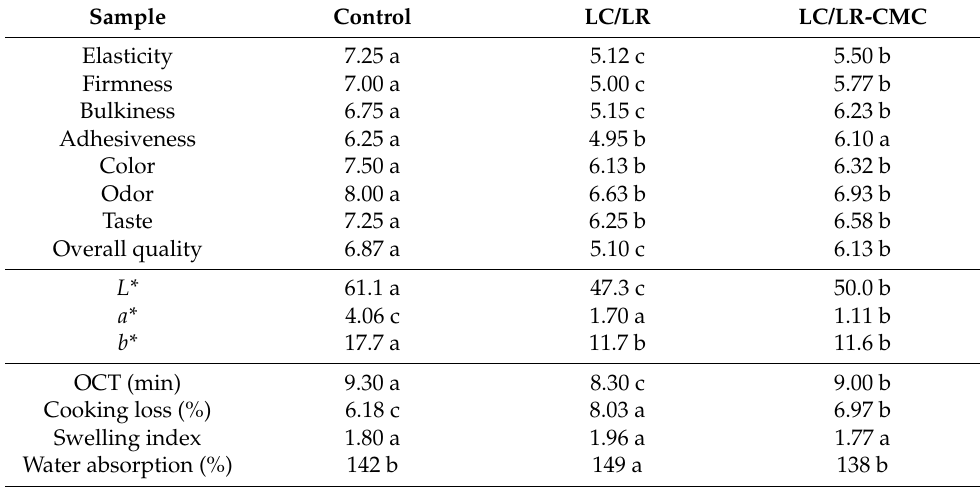
Table 1. Sensory data, color parameters and cooking quality of control and fortified cooked